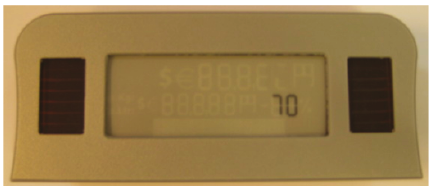
Figure 2: Photo of a fully functional energy harvesting electronic shelf label. This label has updated the price (70) . We also see the two solar cells on this prototype.